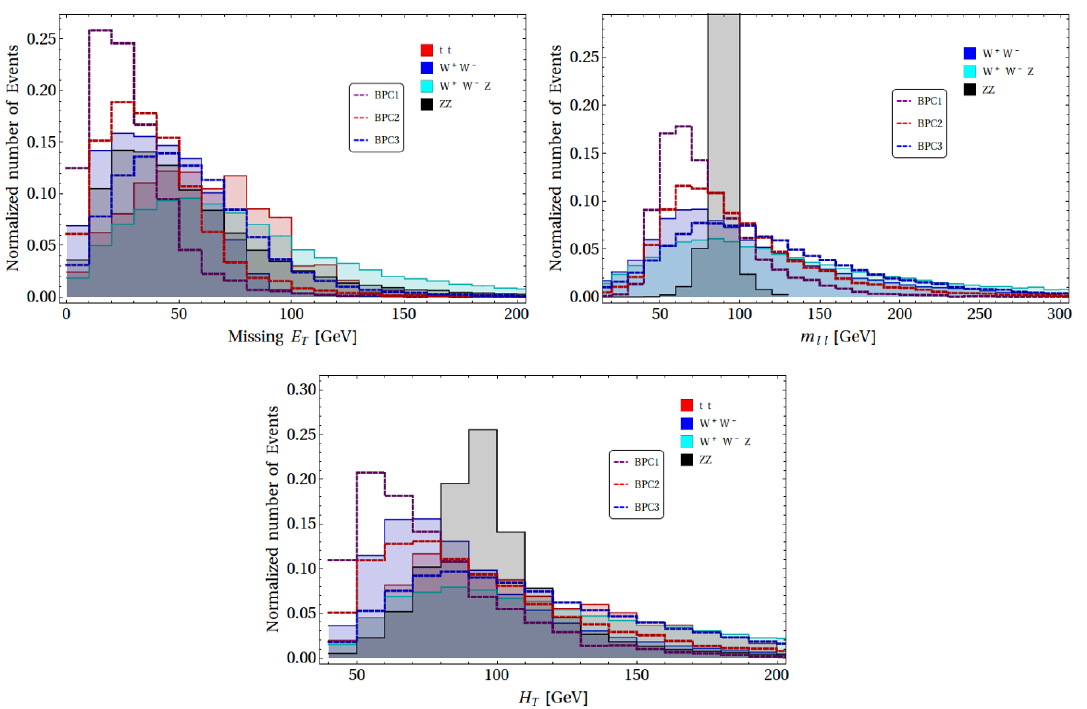
), invariant mass of OSDL ( m T ) and dominant SM background events at LHC with T